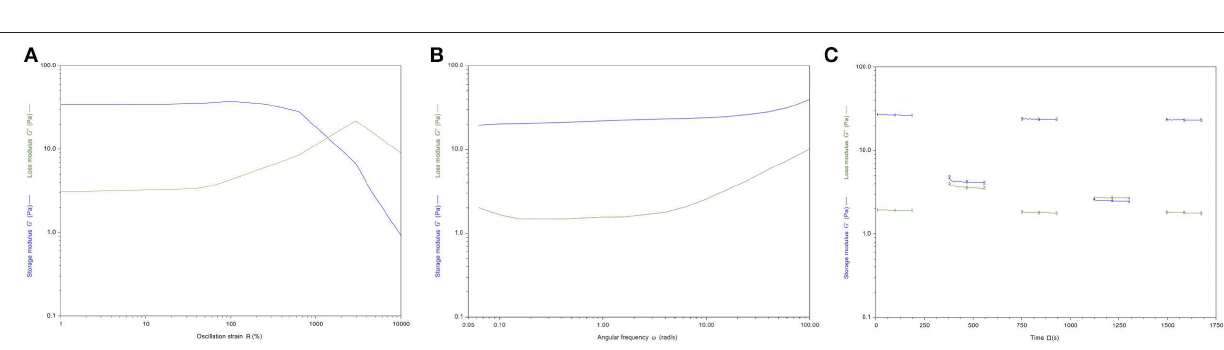
in the LVE zone (2% for all samples). Measurements of